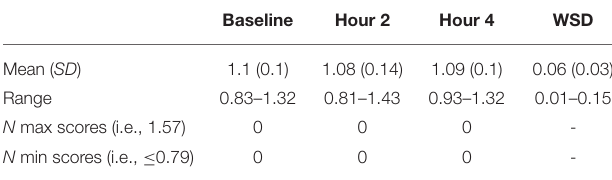
TABLE 2 | OCL48 performance over repeated